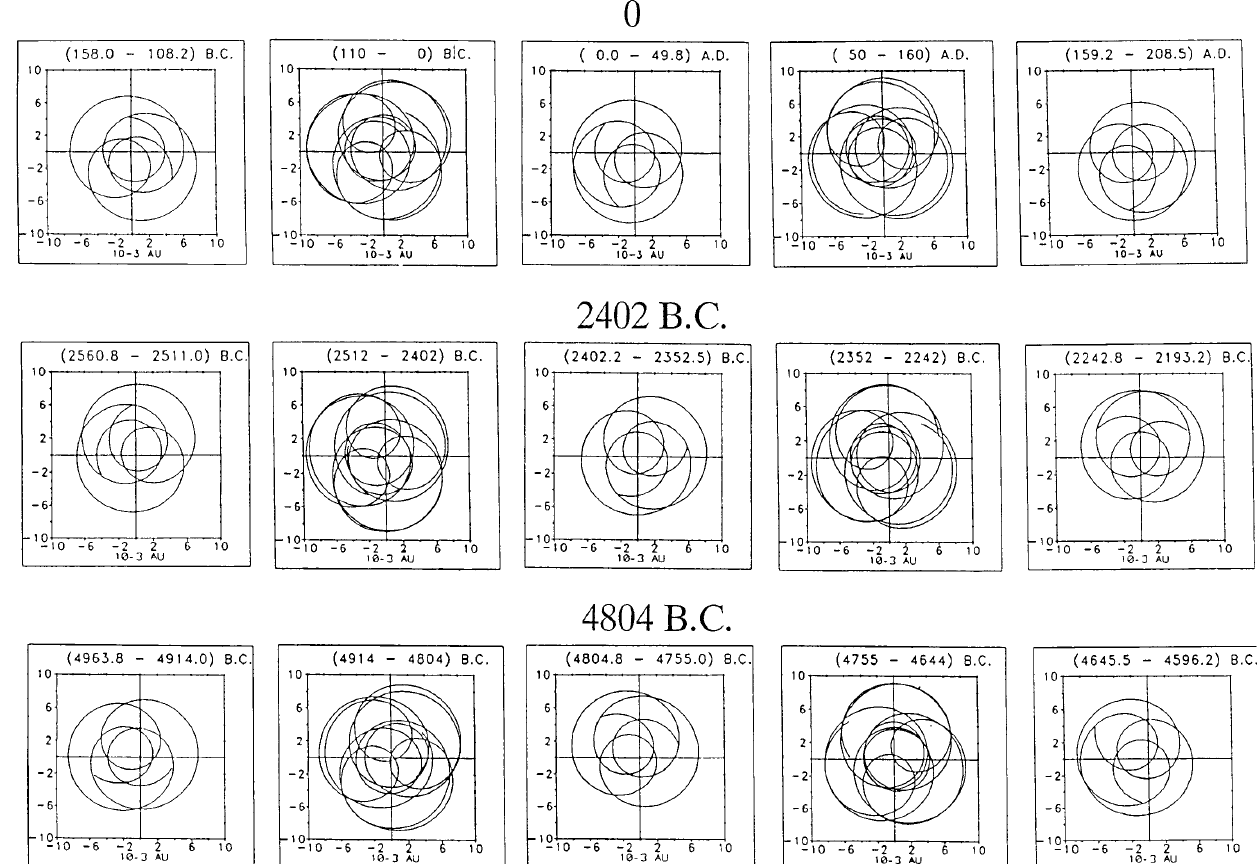
Fig. 4. The 370-year segments of the exceptional, stable pattern of solar motion recurring in steps of 2402 years: notice the twice shortened distance of 159 years between the three trefoils in each